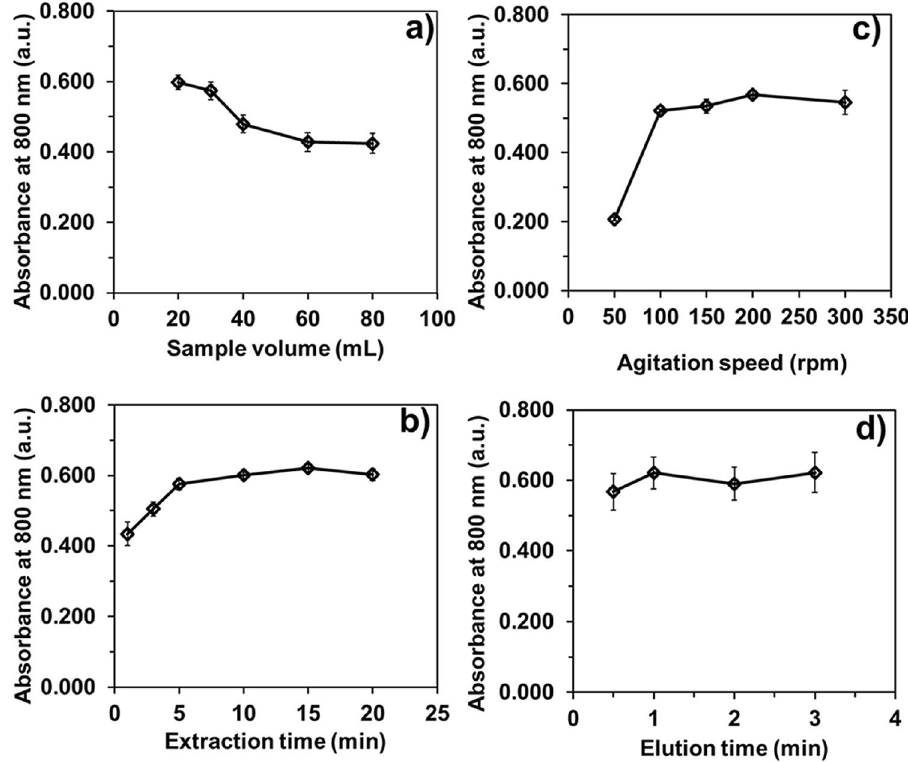
Figure 6. Effect of d-MSPE parameters; ( a ) sample volume, ( b ) extraction time, ( c ) agitation speed, and ( d ) elution time on absorbance signals. Absorbance ± SD, n =